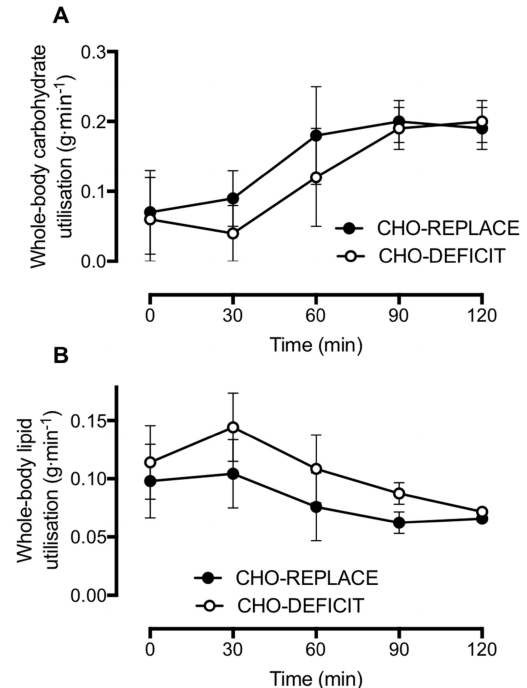
Figure 4. Whole-body carbohydrate ( A ) and lipid utilization ( B ) during an oral glucose tolerance test conducted ~16 h after exercise with either carbohydrate replacement (CHO-REPLACE) or a maintenance of the exercise-induced carbohydrate deficit (CHO-DEFICIT). n = 7. Data are means ± normalized 95%